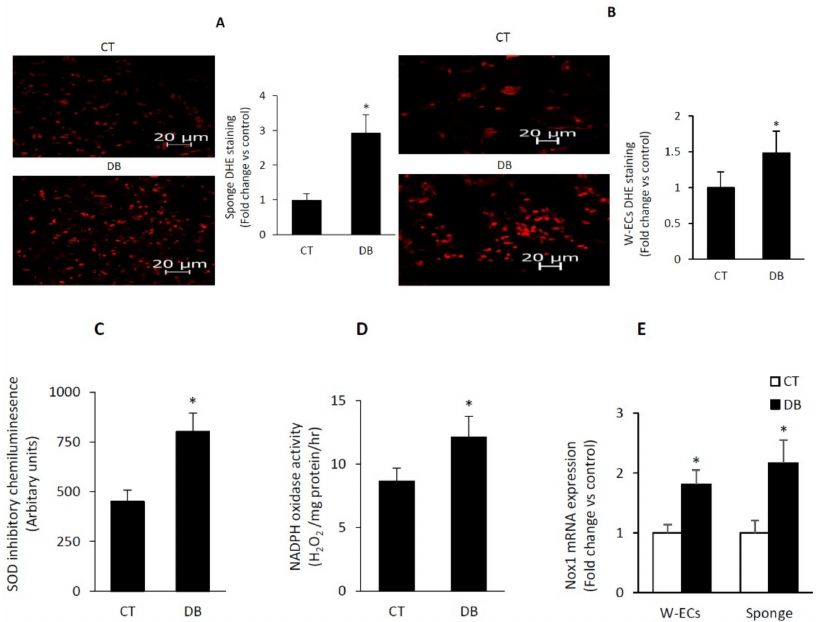
Figure 5. Diabetes induces a heightened state of oxidative stress in cultured W-ECs and in PVA sponge model of wound healing. Representative fluorescence images of DHE staining in W-ECs ( A ) and in PVA sponge model of angiogenesis ( B ); accompanied by a barograph figure denoting DHE staining as fold change vs. control. ( C , D ) NADPH oxidase activity in a membrane fraction of W-ECs was assessed using the lucigenin chemiluminescence- or the Amplex red/horseradish peroxidase fluorescence-based assay. ( E ) Nox1 mRNA expression in W-ECs and PVA sponge model of wound healing was determined using qRT-PCR-based assay. Abbreviation: DHE, dihydroethidium; SOD, superoxide dismutase; W-ECs, wound endothelial cells, CT, control; DB, diabetic. Values are means ± SEM ( n = 6) * Significantly different from corresponding control values at p ≤